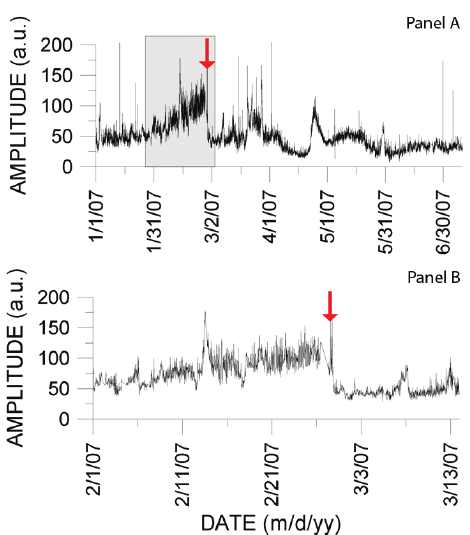
Fig. 8. The trend of the seismic amplitude (STR1, E- W component) in the period from January 1, 2007, to July 10, 2007 (panel A). The red arrow marks the on- set of the effusive eruption. Panel B shows the time window (February 1-March 14, 2007) marked by the gray rectangle in panel A. Before the effusive phase, an increment is evident from the end of